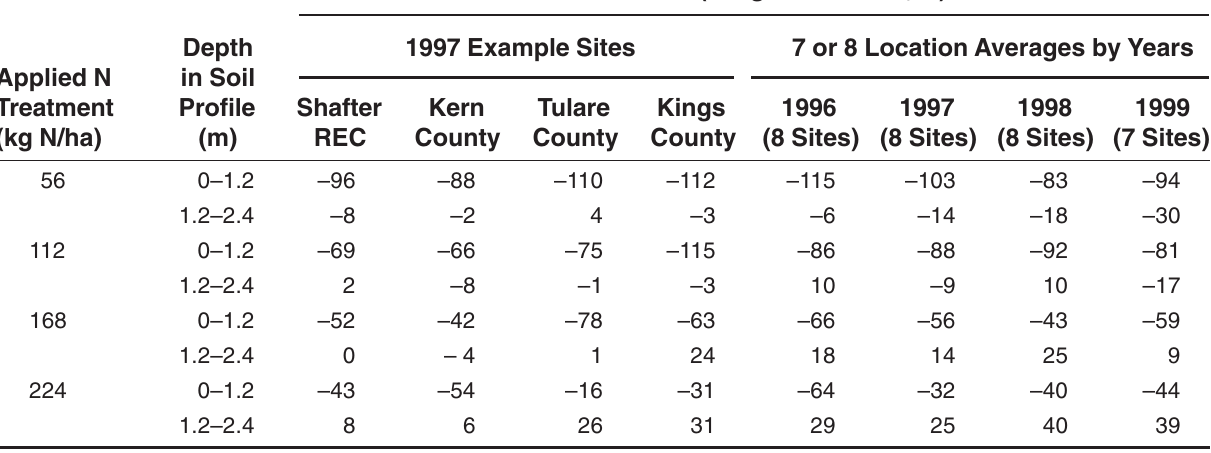
Note: Data for specific 1997 study sites are as shown, while 1996 through 1999 averages were calculated across all -N data is grouped as the soil surface to 1.2-m depth vs. the 1.2- to 2.4-m depth. Negative study sites. Soil NO 3 -N during the period from planting through number (–) indicates net reduction in soil NO 3